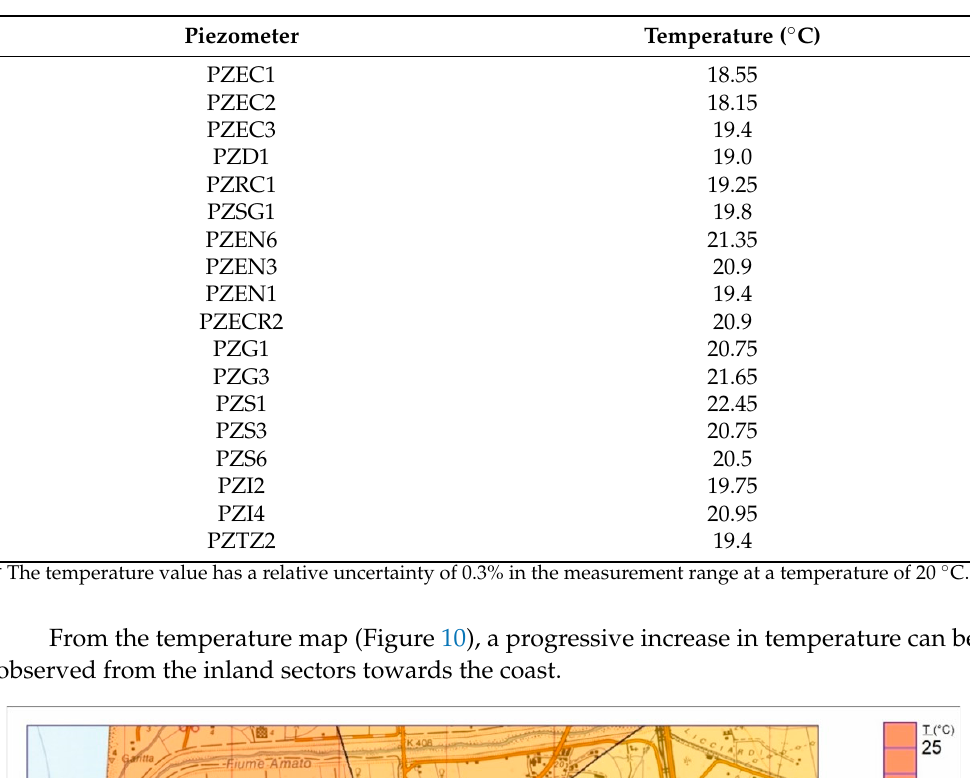
Table 3. Temperature—Median Values [6] *.